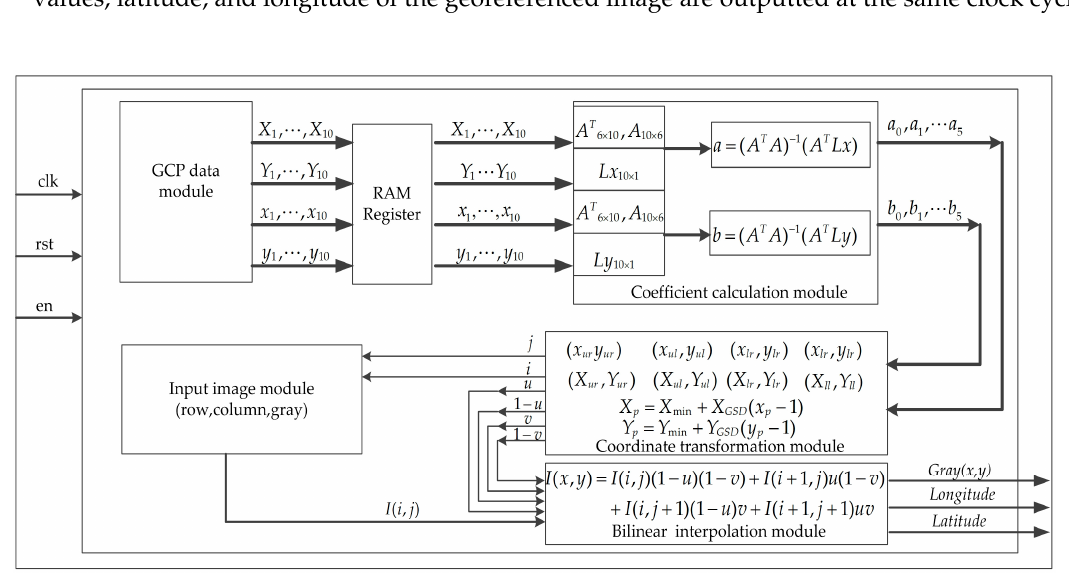
Figure 4. A field programmable gate array (FPGA) architecture for the georeferenced remote sensing images with second-order polynomial equation and bilinear interpolation scheme. RAM: random access